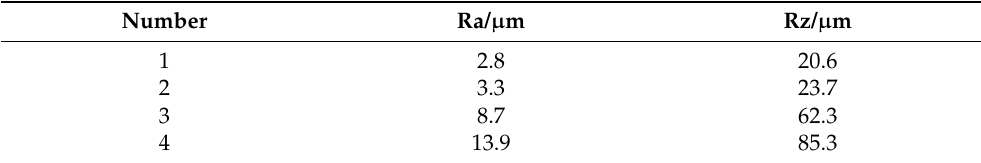
Table 1. Surface roughness of water film test plates.